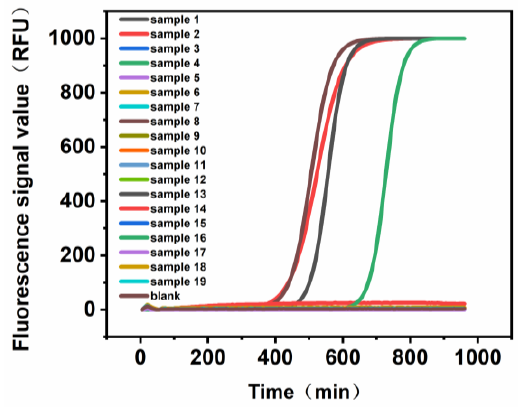
Figure 8. Test results of the actual sample.